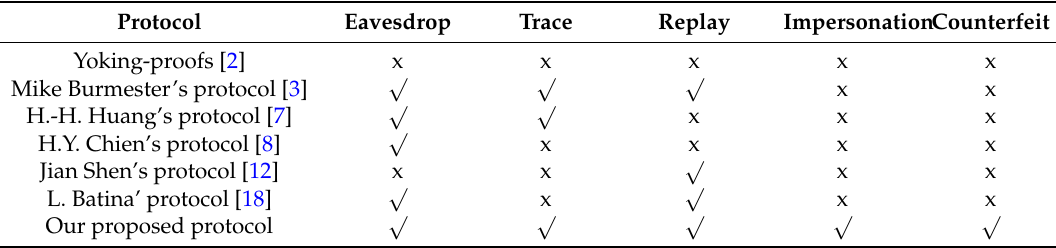
Table 3. The security comparison of the different grouping-proof